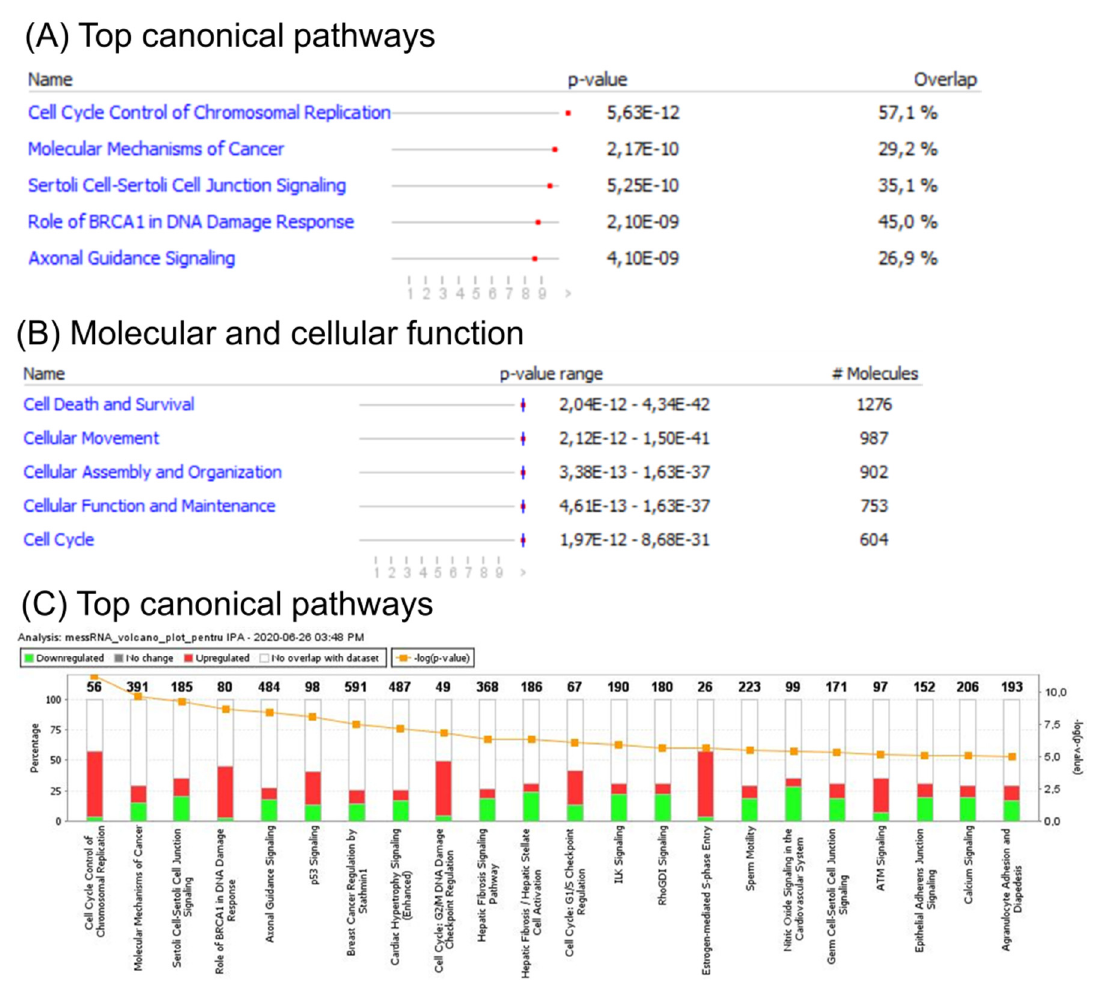
Figure 2. Functional analysis of mRNA altered genes in CC. ( A ) Top canonical pathways; ( B ) top molecular function; ( C ) ingenuity pathway analysis (IPA) of differentially expressed pathways specific to CC. A log Benjamini–Hochberg value higher than 5, p -value ≥ 0.0001, corresponds to a significantly altered pathway. The solid yellow line in the bar graph corresponds to ratios of number of molecules from the dataset that map to the pathway over the total number of molecules that map to the canonical pathway from the IPA knowledge base. The Z score denotes the activation score for either a pathway, disease, or function. This score corresponds to levels of activation (red) or deactivation (green) of a pathway or function due to changes in expression of genes involved in pathways or functions.